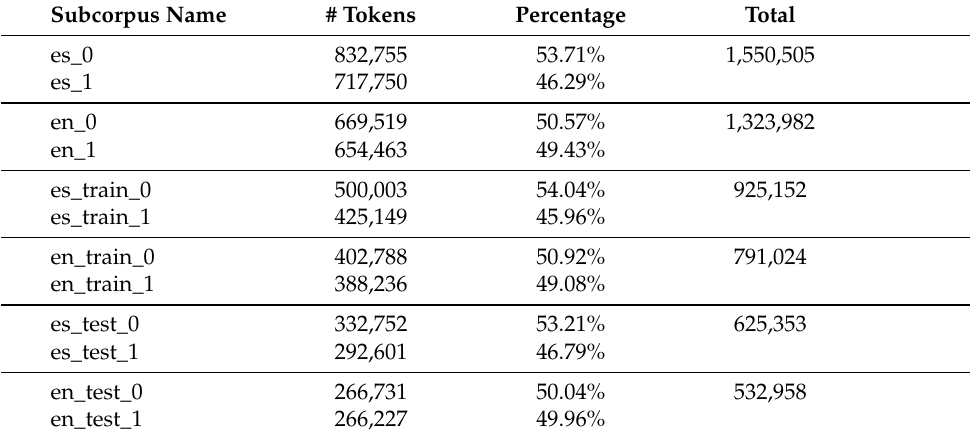
Table 1. Dataset